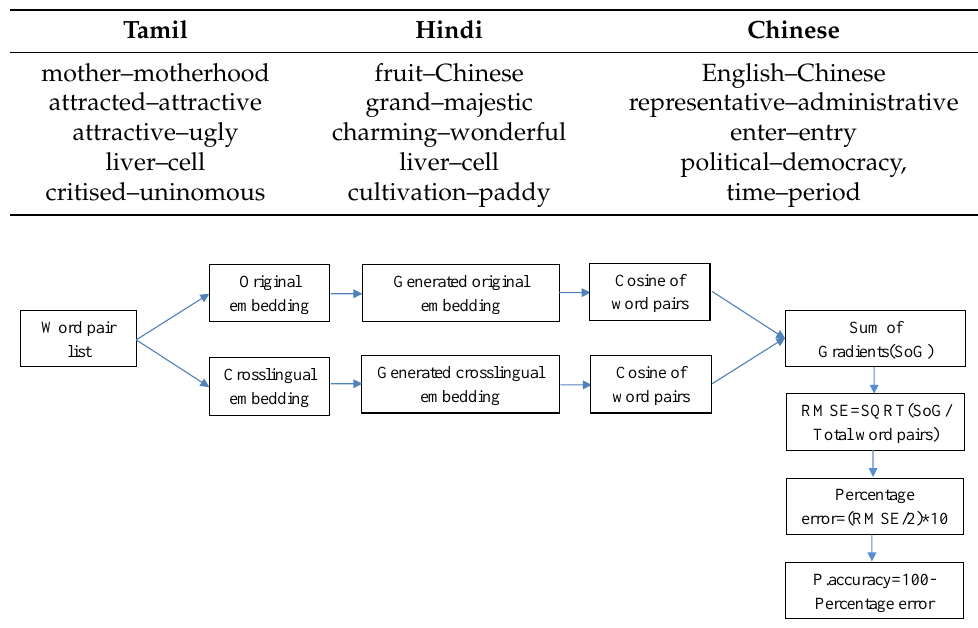
Figure 4. Pipeline for computing pairwise accuracy for similar words.